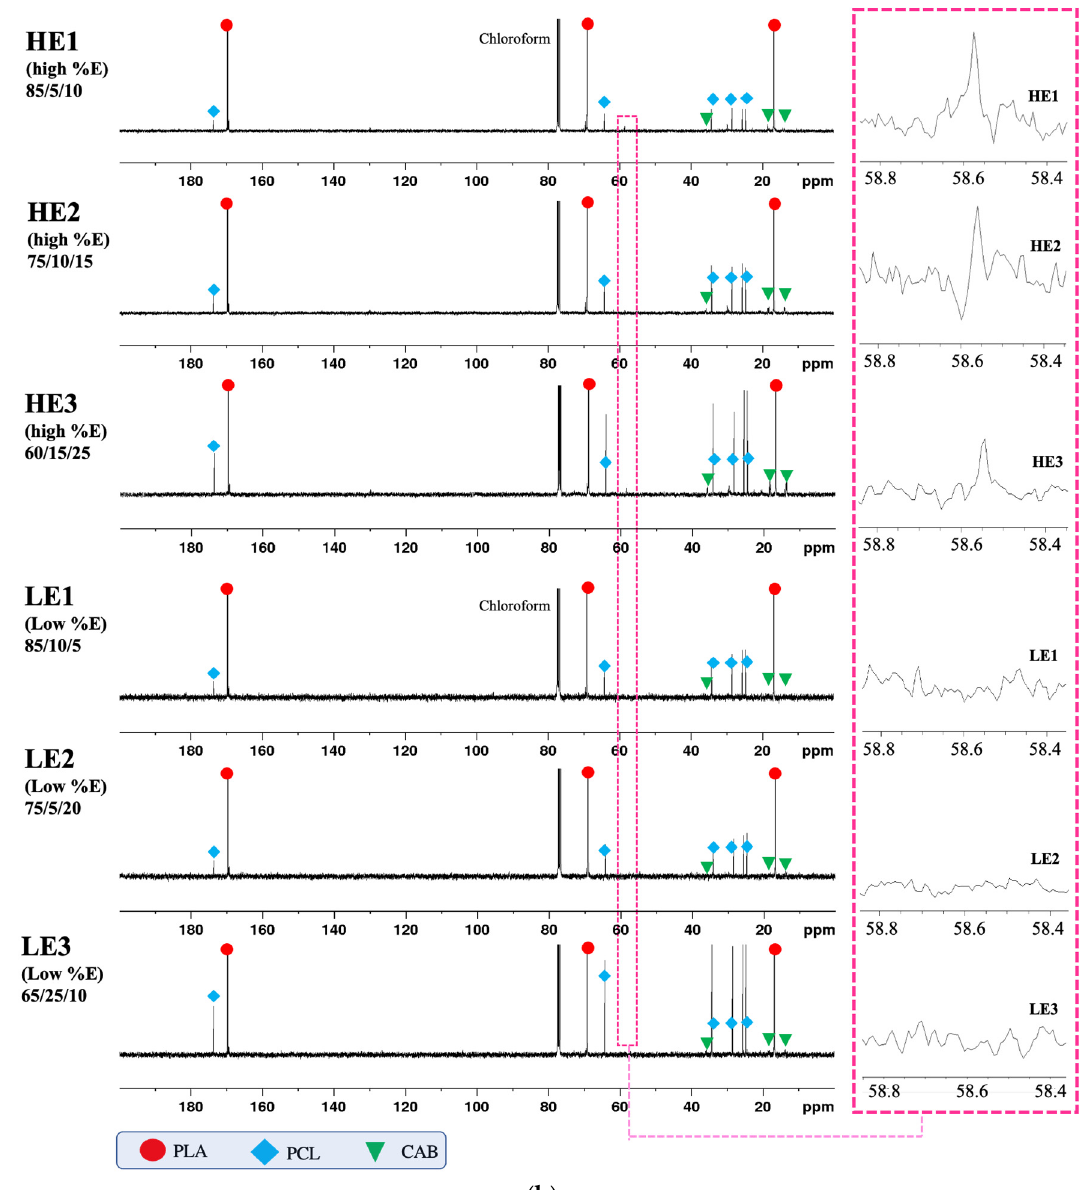
Figure 9. ( a ). 1 H NMR of ternary-blended, melt-blown films of HE and LE films, showing zoom peaks at chemical shift of 3.4–3.8 ppm. ( b ). 13 C NMR of ternary-blended, melt-blown films of HE and LE films, showing zoom peaks at the chemical shift of 58.4–58.8 ppm.